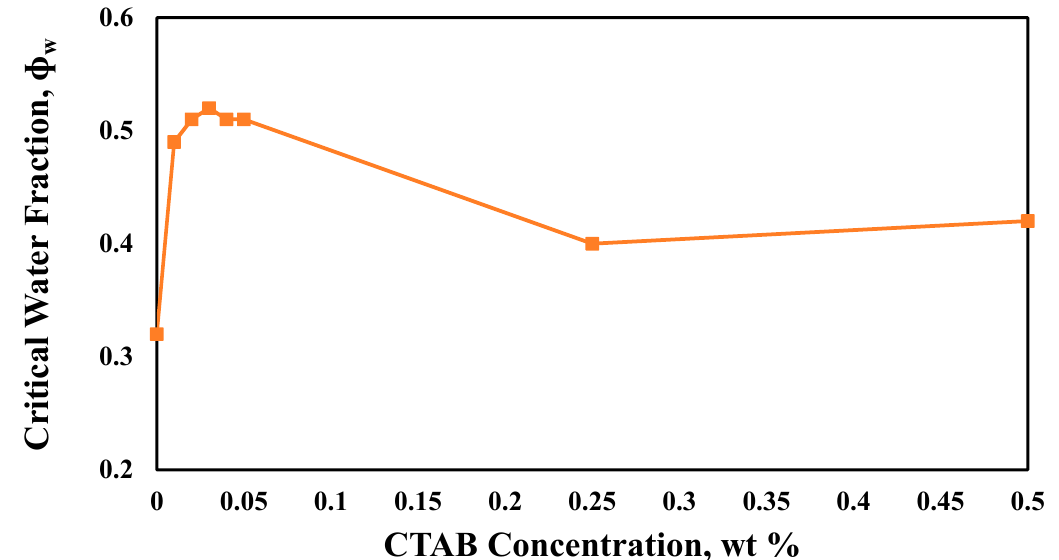
Figure 12. Critical volume fraction of water versus CTAB concentration.